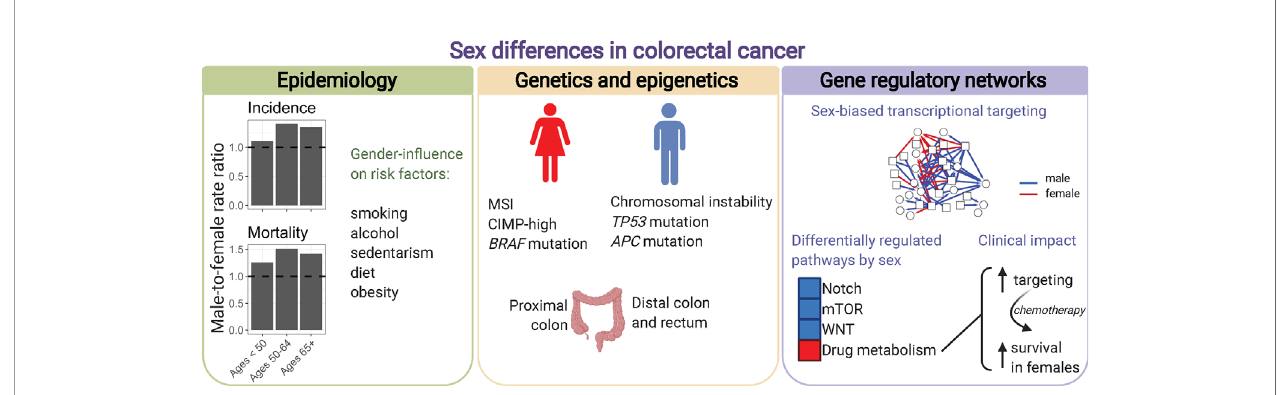
FIGURE 6 | Sex differences in colorectal cancer. Males and females present differences in colorectal cancer incidence, mortality, anatomic site location, genetics, epigenetics, and transcriptional regulatory processes characterized by gene regulatory networks. Incidence and mortality rates per 100,000 individuals in the US were retrieved from the Surveillance, Epidemiology, and End Results explorer (2000 –